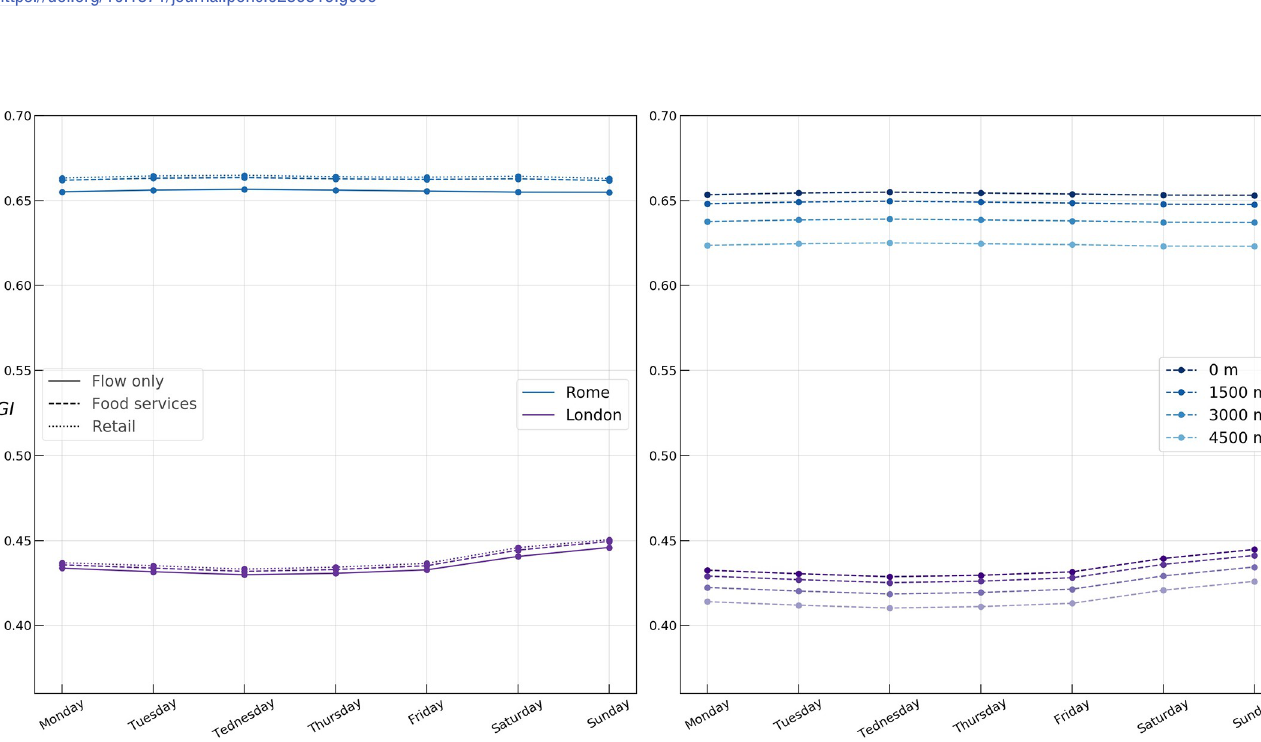
PLOS ONE | https://doi.org/10.1371/journal.pone.0239319 October 14,